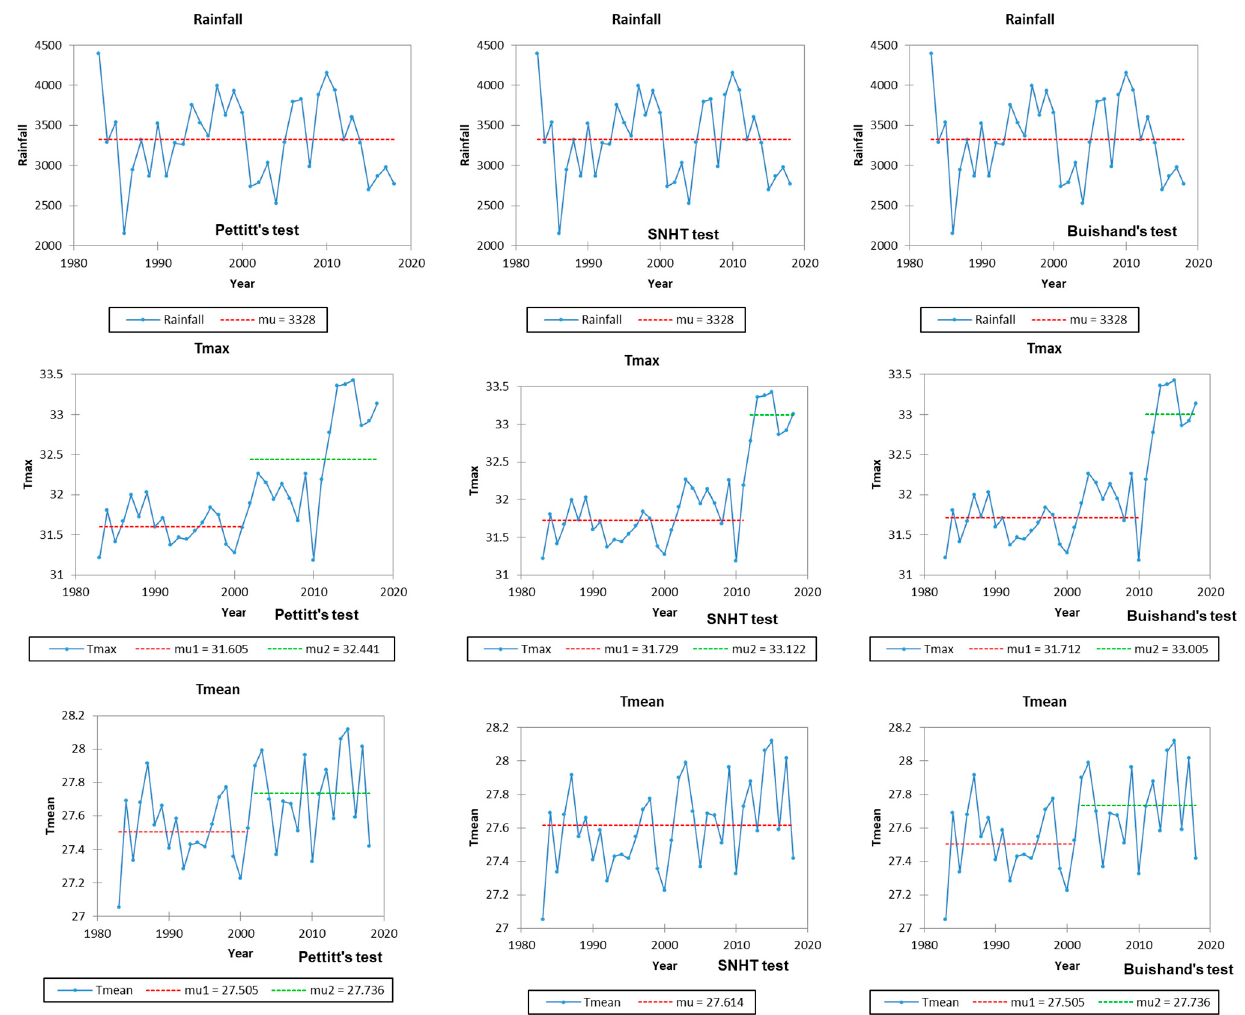
Figure 5. Homogeneity test of annual rainfall, maximum temperature, and mean temperature of Goa